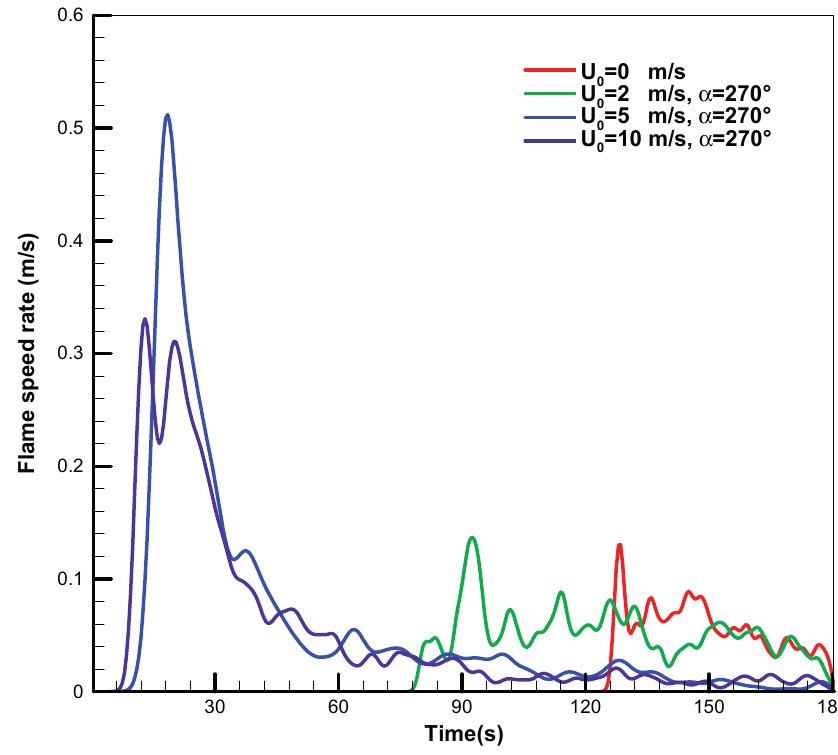
Figure 22. History of the flame spread rate over the skin of the composite-type fuselage for the different wind